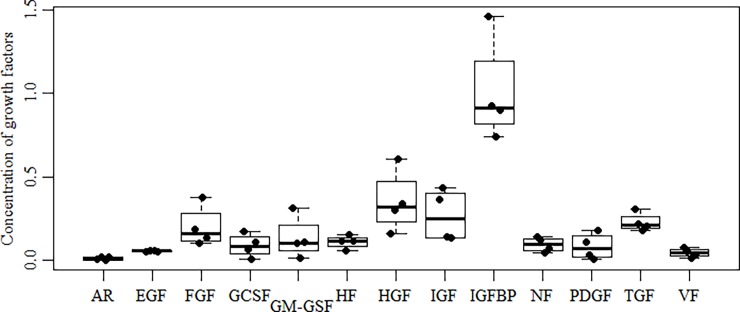
Growth factors in hAM CCM.Forty-one growth factors were quantitated by antibody array and the obtained values were combined into following growth factor families: EGF family (EGF-2, HB-EGF, EGF-R); FGF family (bFGF, FGF-4, FGF-6, FGF-7); Hematopoietic factors HF (MCSF, MCSF-R, SCF, SCF-R); IGF family (IGF-1, IGF-2, IGF-1SR); IGFBP family (IGFBP-1, IGFBP-2, IGFBP-3, IGFBP-4, IGFBP-6); Neurotrophic factors NF (bNGF, GDNF, NT-3, NT-4); PDGF family (PDGF-AA, PDGF-AB, PDGF-BB, PDGF-Ra, PDGF-Rb); TGF family (TGF-α, TGF-β, TGF-β2, TGF-β3); Vasculogenic factors VF (PLGF, VEGF, VEGF-R3, VEGF-D, VEGF-R2); some growth factors are presented separately: AR; G-CSF; GM-CSF; HGF. Each growth factor fluorescence value (FV) was measured and calculated as described in Materials and methods. (n = 4) (p < 0.05).